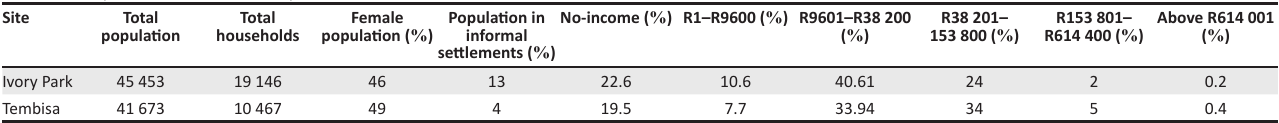
TABLE 1: Ivory Park and Tembisa, comparative socio-economic indicators. Site Total